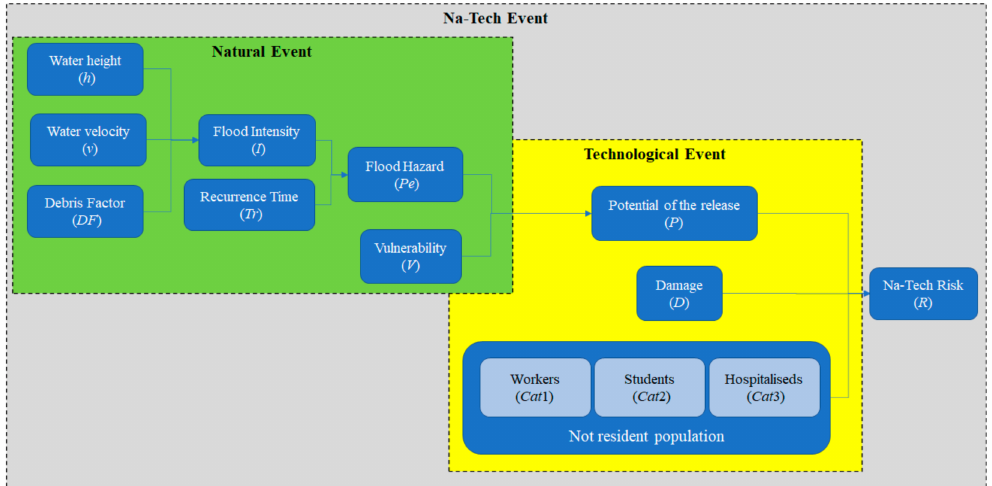
Figure 4. Flow-chart of the procedure assessing the flood Na-Tech